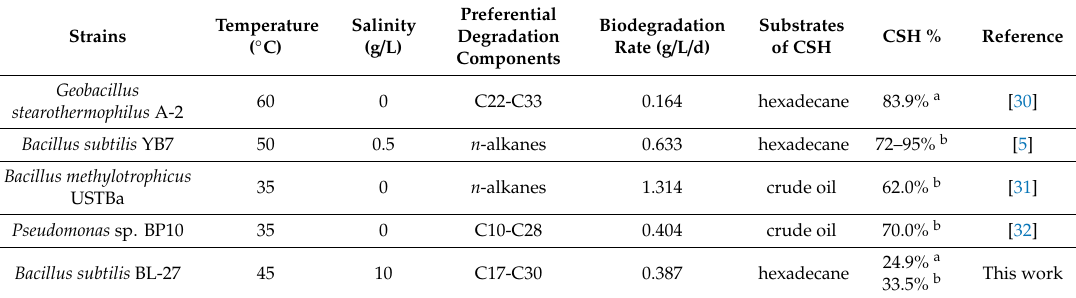
Table 3. The characteristics of some crude oil-degrading